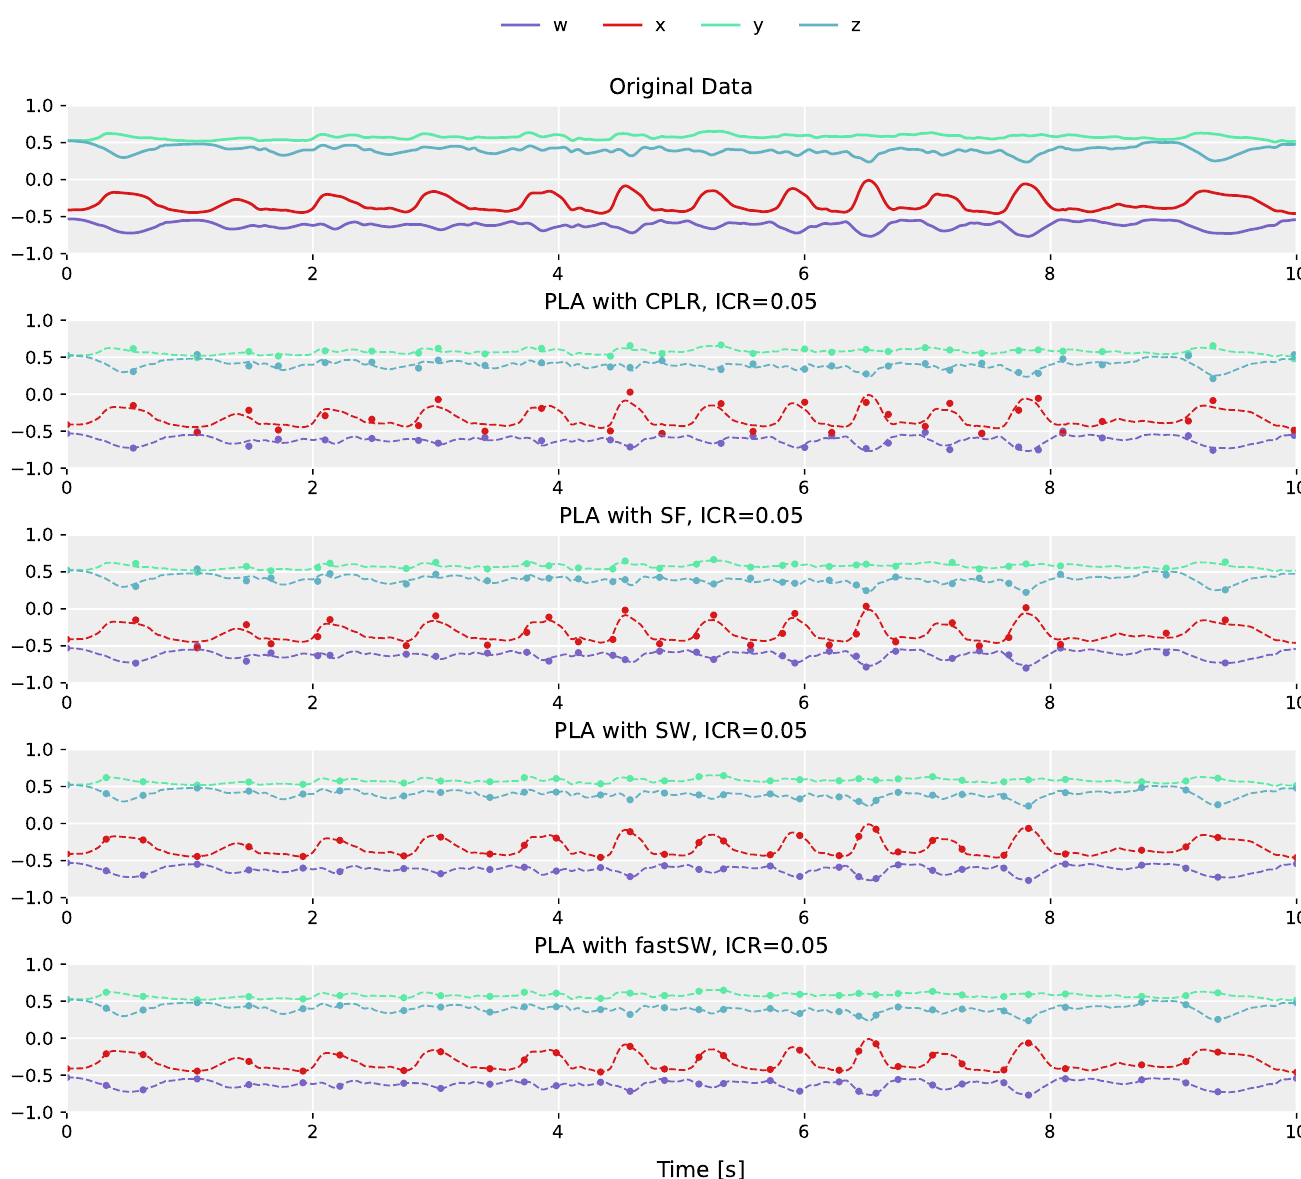
Figure 2. Example of the different PLA method outputs at a compression ratio of approximately 5% the size of the original data. Shown is the quaternion data from the left shank of the fast-paced running on spot activity of user MR from the TNT15 dataset, with the original data at the top, and the produced segment points overlaid over the original data by the algorithms (from top to bottom): CPLR, SF, SW, and fastSW (our proposed method). CPLR and SF produce segment points that are not a subset of the original data, while SW and fastSW produce segment points that lie on the original